Question: In one sentence, what is this figure communicating?
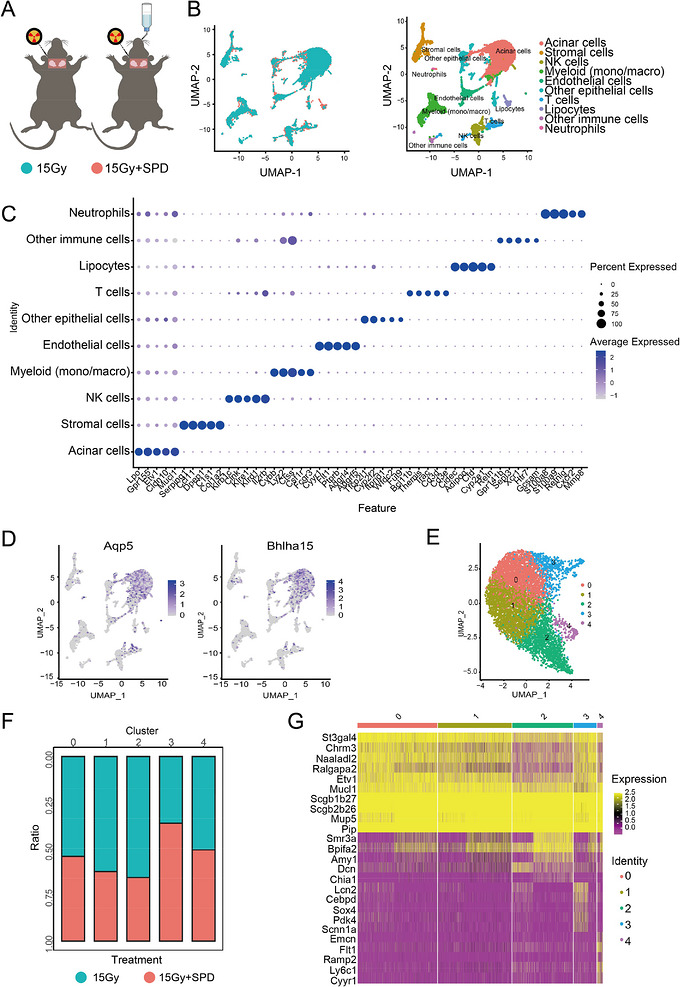
Answer: Single‐cell RNA (scRNA)‐seq reveals protective mechanism of spermidine against radiation‐induced submandibular gland injury. (A) Study protocol. (B) Distribution of subgroups of cells in 15 and 15 Gy + SPD groups. (C) Expression levels of cells in 15 and 15 Gy + SPD groups. (D) Distribution of acinar cell diversity. (E) Subgroups of the acinar cell population. (F) Clusters of different subgroups of cells in 15 and 15 Gy + SPD groups. (G) Heat maps showing the different expression levels of genes (yellow refers to up‐regulation and pink refers to downregulation).